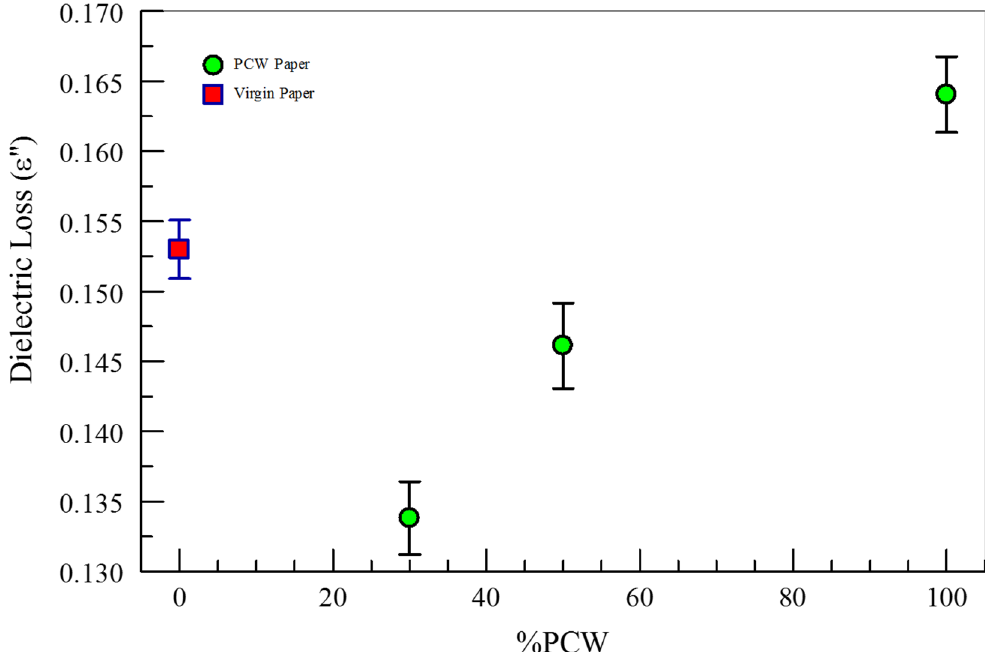
Figure 1. Comparison of the dielectric loss of office copier papers manufactured with varying concentrations of post-consumer waste (PCW) recycled fiber content to that of virgin paper (with 0% PCW) produced by manufacturer B. The error bars represent the standard deviation of the dielectric loss measurements of at least six samples.